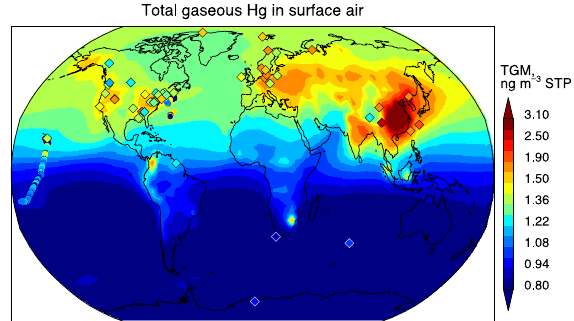
Figure 3. Global distribution of total gaseous mercury (TGM) con- centrations in surface air in units of ngm − 3 STP ( p = 1atm, T = 273K). Model values (background) are annual means for 2009– 2011. Observations (symbols) are for 2007–2013. Data for land sites (diamonds) are annual means for 2007–2013 as previously compiled by Song et al. (2015) and Zhang et al. (2016). Obser- vations from 2007–2013 ship cruises (circles) are from Soerensen et al. (2013, 2014). Note the change in the linear color scale at 1.50ngm − 3